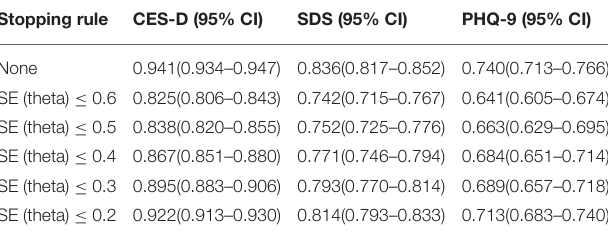
TABLE 6 | Criterion-related validity of CAT-Depression with external criteria scales under different stopping rules. Stopping rule CES-D (95% CI) SDS (95%